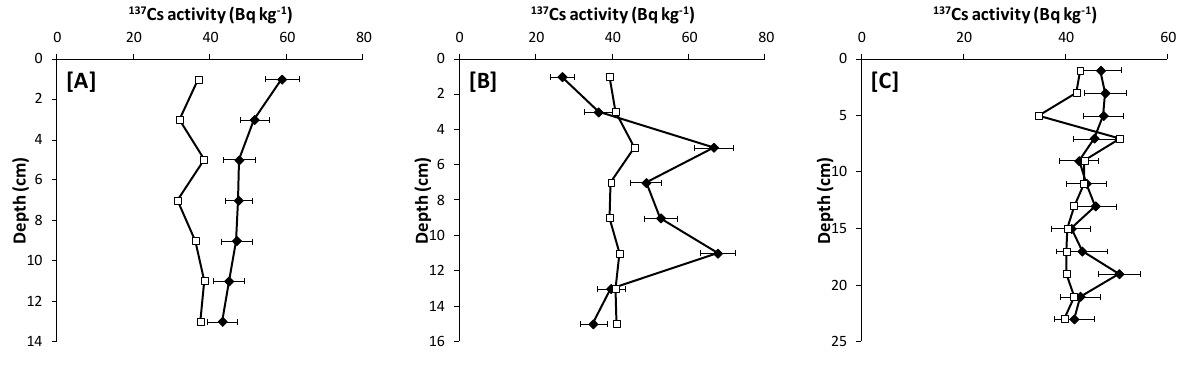
Figure 3. 137 Cs activity profiles of sediments from three sites in the Bonny estuary. ( A ) BNN1, upstream site; ( B ) BNN2, point of industrial activity; ( C ) BNN3, downstream site. Open symbols are the detection limit for each sample. Error bars represent 1σ uncertainties based on the propagation of counting